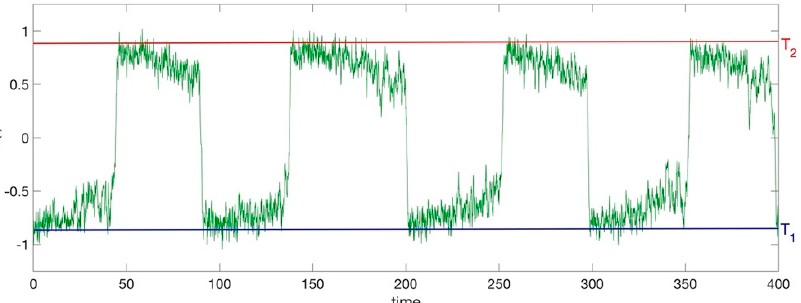
Figure 5. Solution x(t) = T(t) of the generalized Langevin’s equation for the following parameters: a = 0.46 and α = 0.23. As it can be seen, under such conditions, the system jumped from the left well to the right well, giving rise to a periodic oscillation between the two wells, with the same period of the external disturbance, which correspond to the glacial, at temperature T 1 , and interglacial, at temperature T 2 , states.